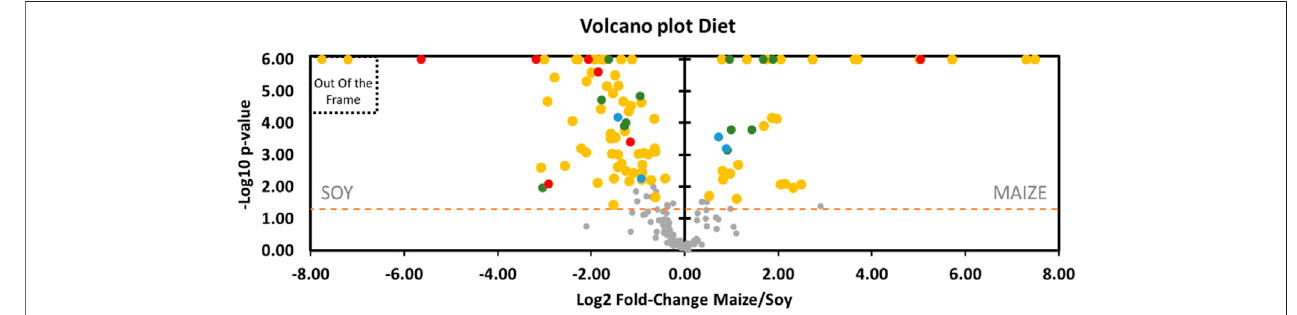
FIGURE 8 | Volcano plot showing metabolomic data in rats ( n = 57) according to the diet. Fecal metabolites over-expressed in rat fed maize are on the right and thosefedwithsoyareontheleft.Thedashedlineshowswhere p =0.05withpointsabovethelinehaving p < 0.05andpointsbelowthelinehaving p > 0.05,accordingto the 2-way ANOVA. Colors of the dots are in accordance with the Venn diagram. Red dots are for Diet*Pressure*Interaction, for example. Grey dots are not signi fi cant according to the 2-way ANOVA and the post-hoc testes. Please note, 2 yellow dots are out of the frame: Dipalmitoylglycerol (log2FC = − 53) and Trans-3- hydroxycinnamic acid (log2FC = − 51). Details are presented in Supplementary Data 1 .